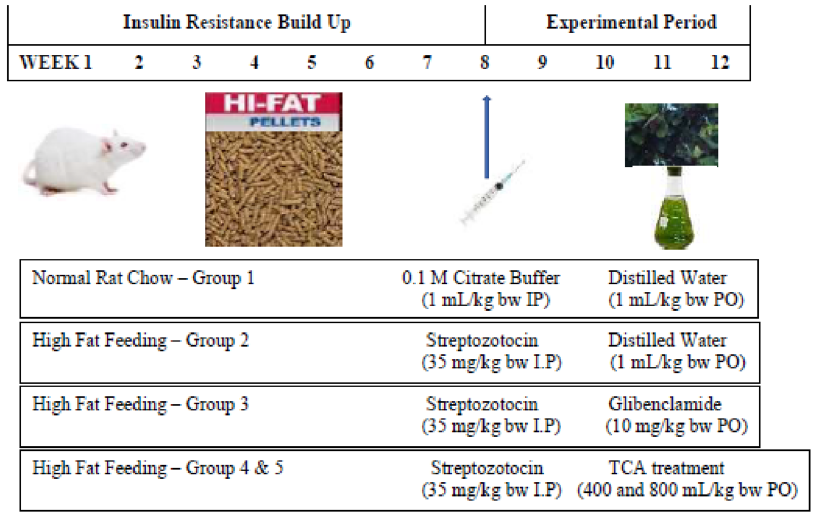
Figure 1. Experimental